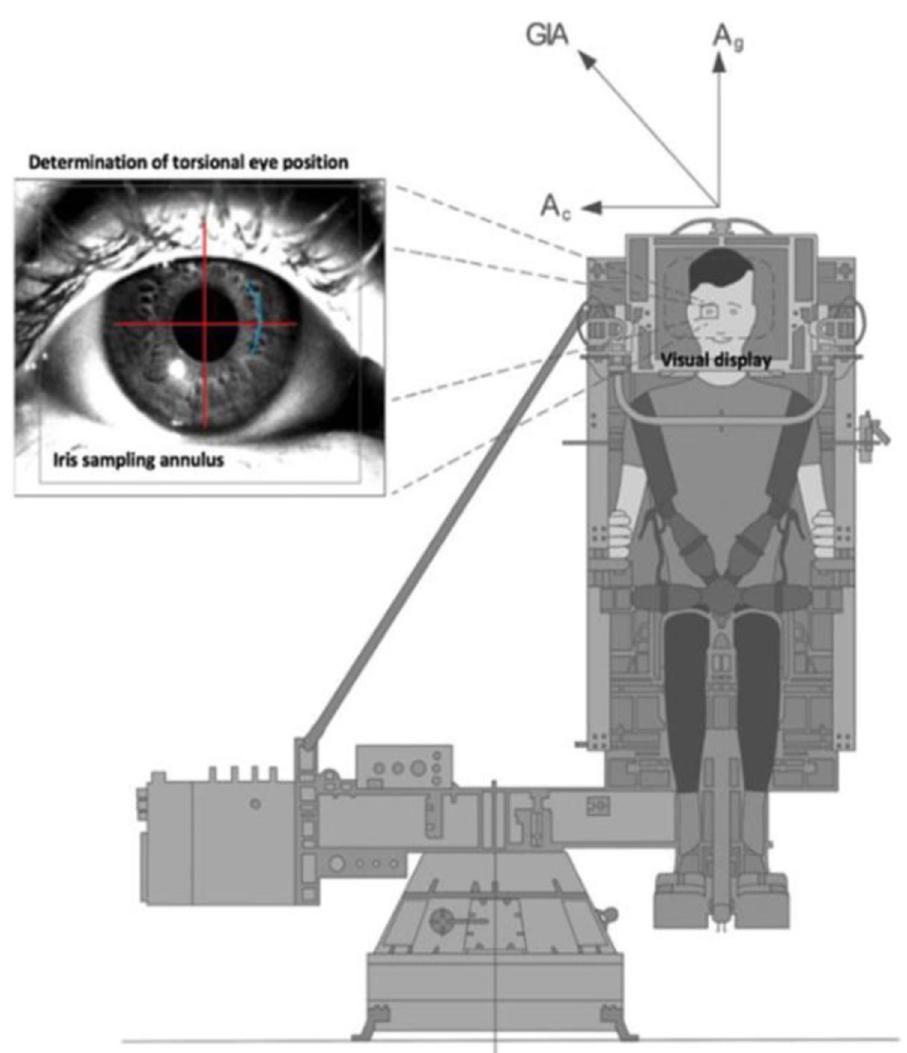
Fig. 2 Representation of experimental setup. The net linear acceleration stimulating the otoliths, during off-axis centrifugation, is the vector sum of the gravitational (Ag) and centripetal acceleration (Ac), termed the Gravito-Inertial Acceleration (GIA). When GIA was interpreted as the spatial vertical during centrifugation, the cosmonaut should experience a sensation of 45° tilt (Reprinted from ref. 8 with permission of Macmillan Publishers Ltd, copyright